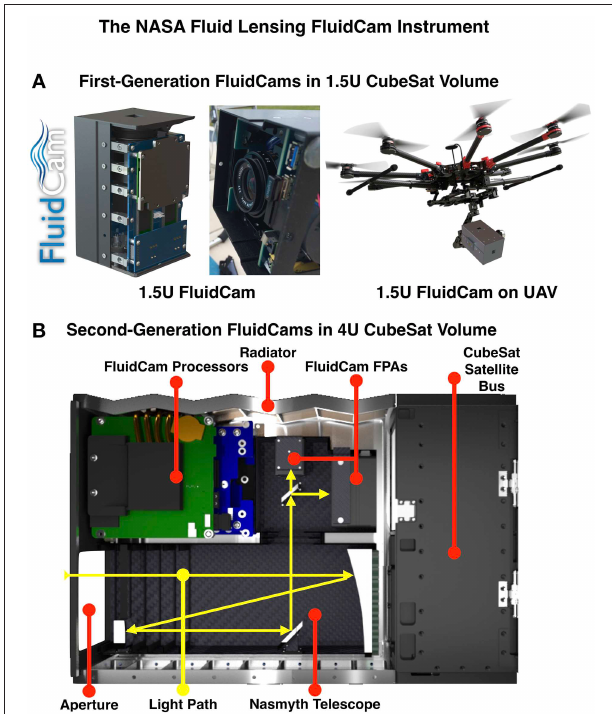
FIGURE 5 | The NASA Fluid Lensing FluidCam instrument. (A) A cutaway render and image of the first-generation FluidCam, which fits in a 1.5U CubeSat volume is shown alongside the instrument mounted on a UAV for airborne mapping missions. (B) The second-generation FluidCam consists of a 4U instrument payload for a 6U CubeSat. The new architecture affords multiple larger focal plane arrays, improved optical performance, and a heterogeneous CPU/GPU processing stack optimized through the SpaceCubeX